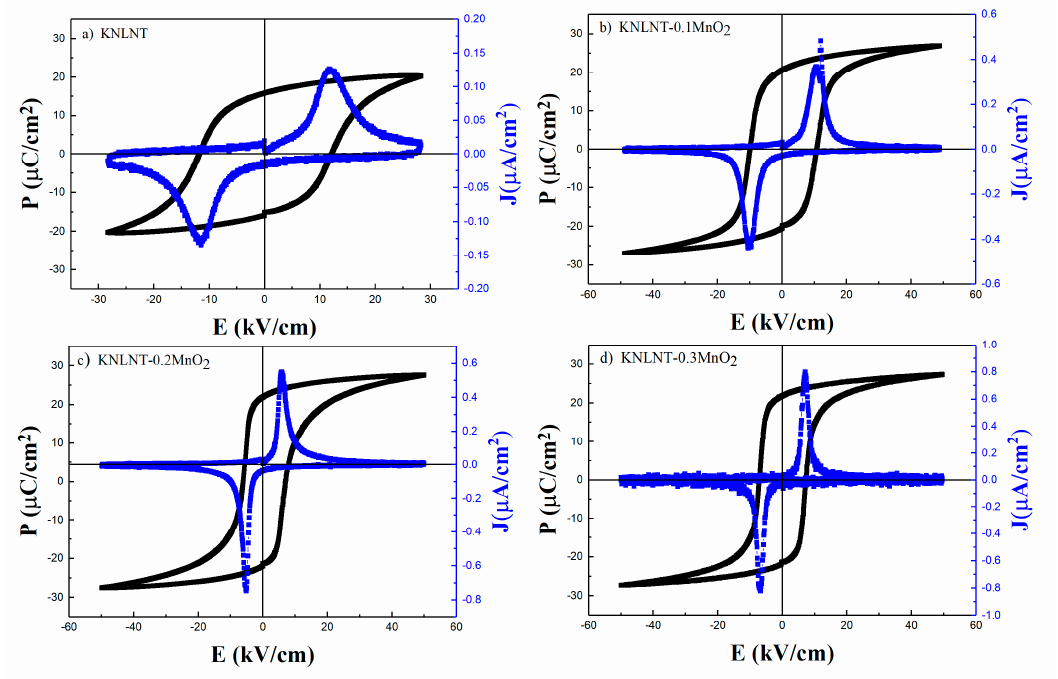
Figure 3. P-E loops and J-E curves of KNLNT- x Mn ceramics: ( a ) x = 0.0, ( b ) x = 0.1, ( c ) x = 0.2, ( d ) x = 0.3.